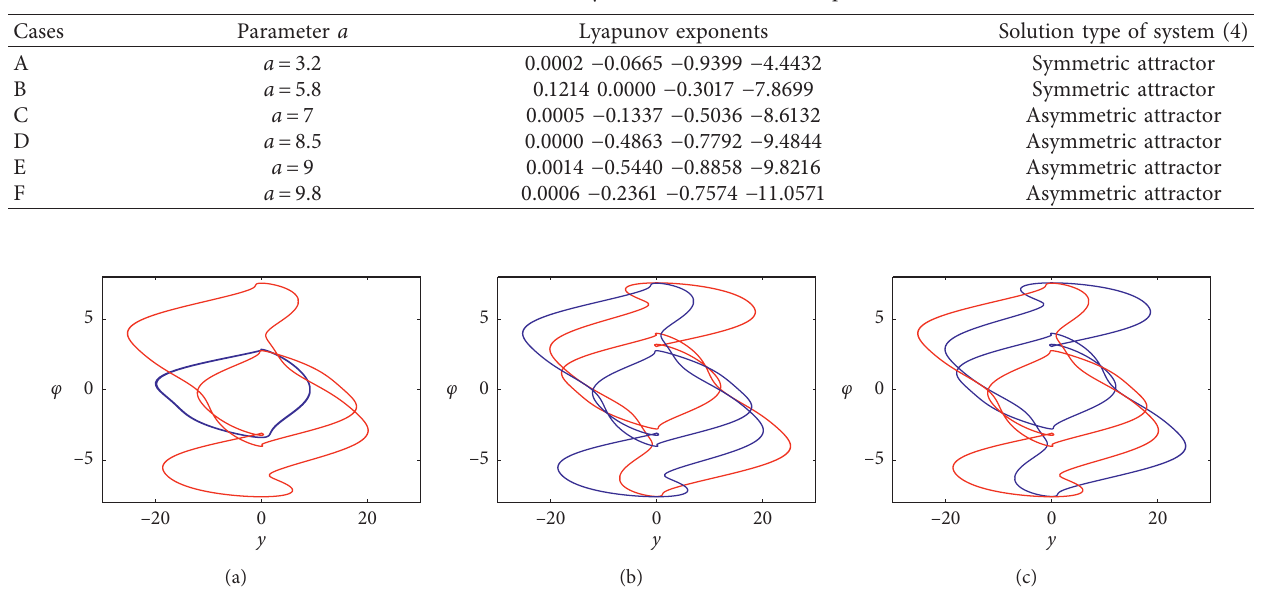
Figure 7: Various periodic oscillations in system (4) with a � 7, b � 3, c � 5, d � 0.75, and k � 1: (a) IC � (0.1, 0.1, 0.1, 0.1) is blue, (0.1, − 0.1, 0.1, 0.1) is red, (b) IC � (0.1, 5, 0.1, 0.1) is blue, (0.1, − 5, 0.1, 0.1) is red, and (c) IC � (0.1, 10, 0.1, 0.1) is blue, (0.1, − 10, 0.1, 0.1) is